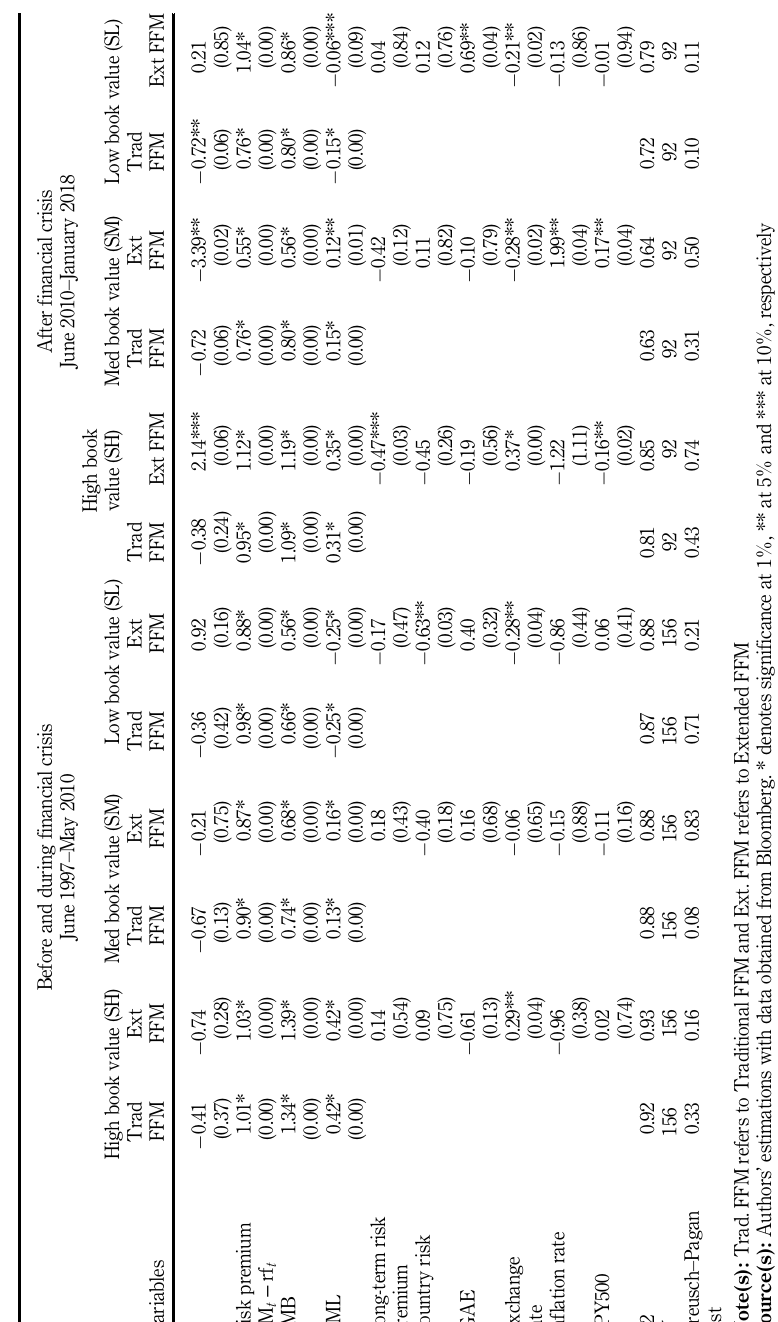
Table 5. Results Portfolio small- capitalization firms